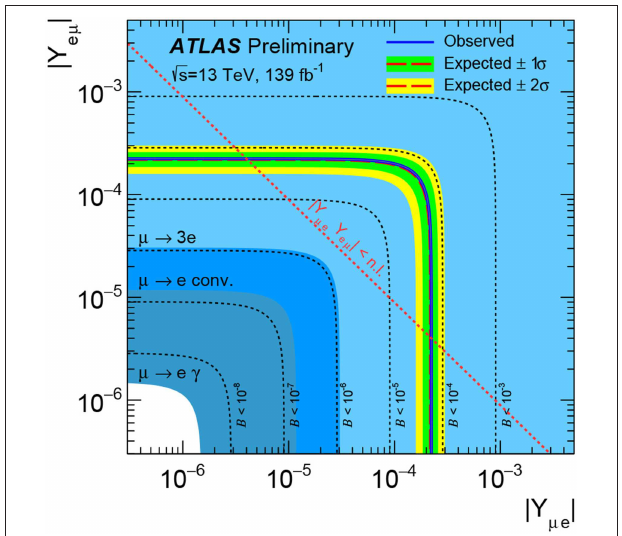
FIGURE 6 | Constraints on the flavor-violating Yukawa couplings Y e µ and Y µ e derived analogously to the relation (4). The expected (red dashed line) and e µ ) from observed (blue solid line) limits are derived from the limits on B ( H → the present analysis. The green (yellow) band indicates the range that is expected to contain 68% (95%) of all observed limit excursions. The shaded regions show the indirect constraints derived using the model calculations of e γ [60], µ e reference [ 55] from null searches for µ 3 e [61], and µ → → → conversions on gold nuclei [62]. For these calculations the flavor diagonal Yukawa couplings are taken to be the SM values. The diagonal line indicates Y e µ Y µ e < m e m µ / v 2 , where v is the vacuum the so-called naturalness limit | | expectation value of the Higgs field. Reproduced from ATLAS Collaboration